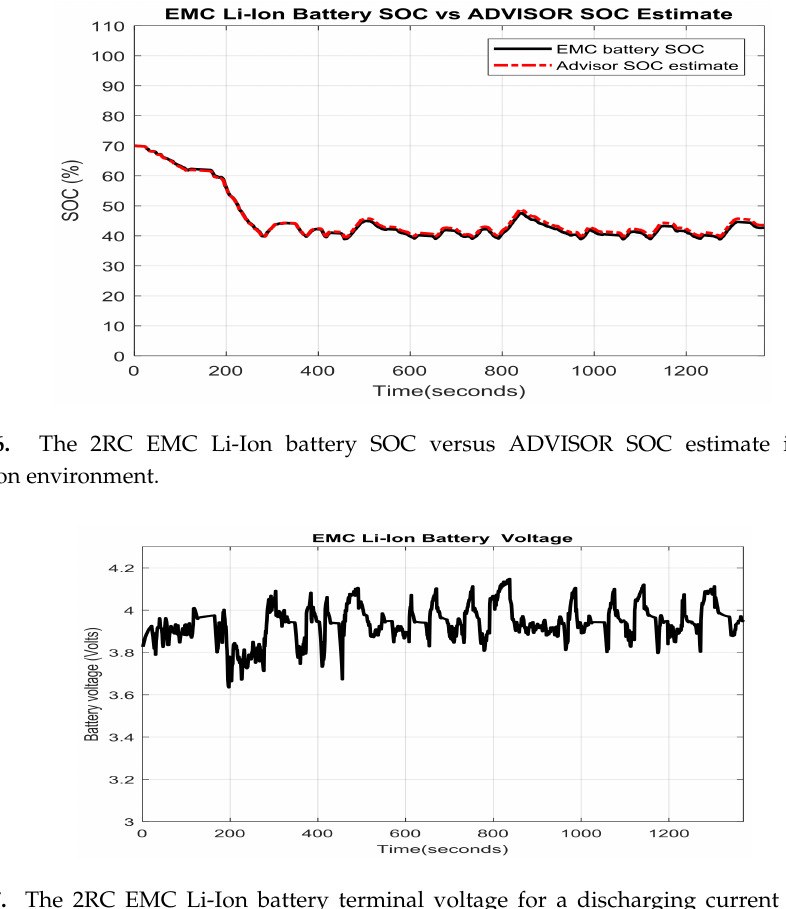
Figure 7. The 2RC EMC Li-Ion battery terminal voltage for a discharging current UDDS cycle FTP-75